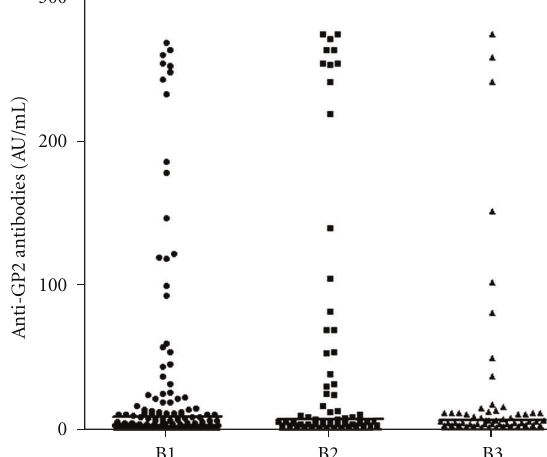
Figure 4: Comparison of IgA and IgG ASCA titres in IgG anti-GP2 antibody positive and negative patients with Crohn’s disease (CD). Statistical analysis did not reveal significant di ff erences amongst anti-GP2 antibody positive and anti-GP2 antibody negative CD patients in ASCA titres.